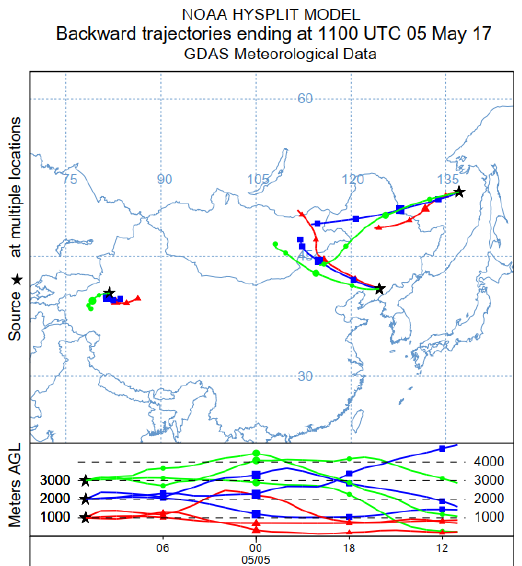
Figure 15. HYSPLIT 24 h backward trajectory for different dust detections in dust storms on 5 May 2017 by night (https://www.ready.noaa.gov/index.php, accessed on 1 December 2021).